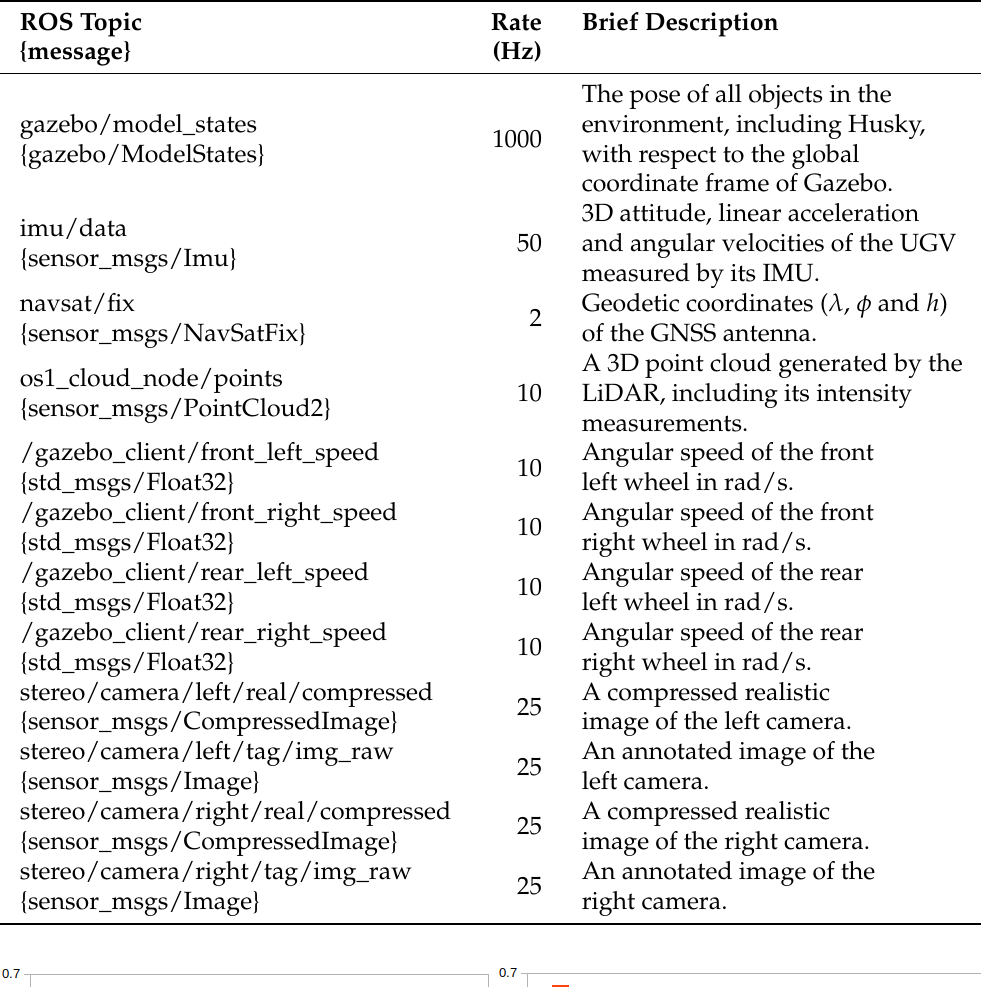
Table 5. Main contents of a bag file of the synthetic dataset.